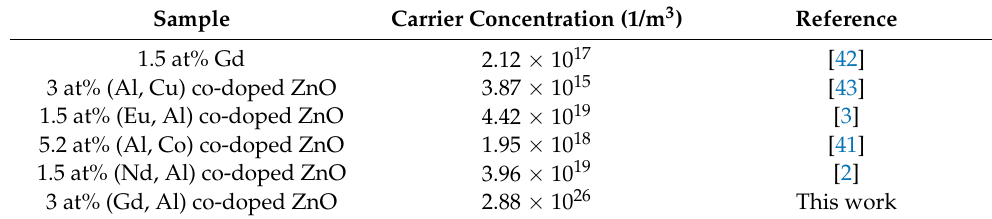
Table 5. Literature of carrier concentration of ZnO-based DMS